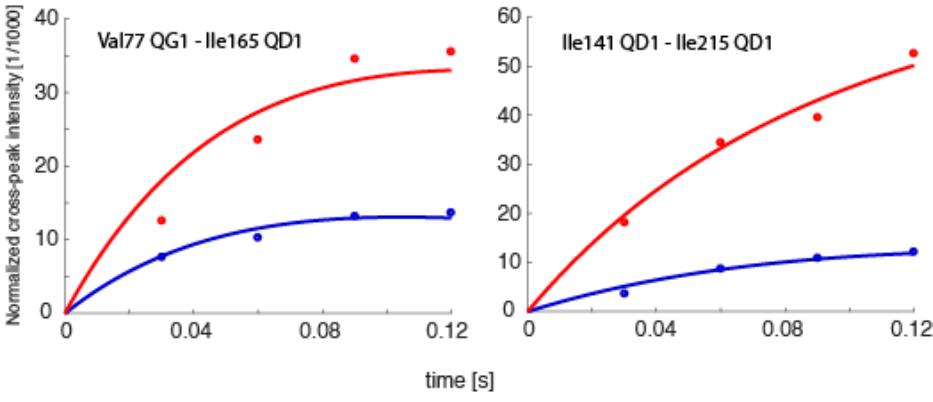
Figure 9. NOE buildup curves obtained from the 360 kDa half-proteasome. Bi-directional buildup intensities for the spin pairs Val77Q γ 1–Ile165Q δ 1 and Ile141Q δ 1–Ile215Q δ 1 are shown. The intensities are normalized to the diagonal-peak intensities at the onset of mixing, which are obtained together with auto-relaxation rates from fits to the diagonals.